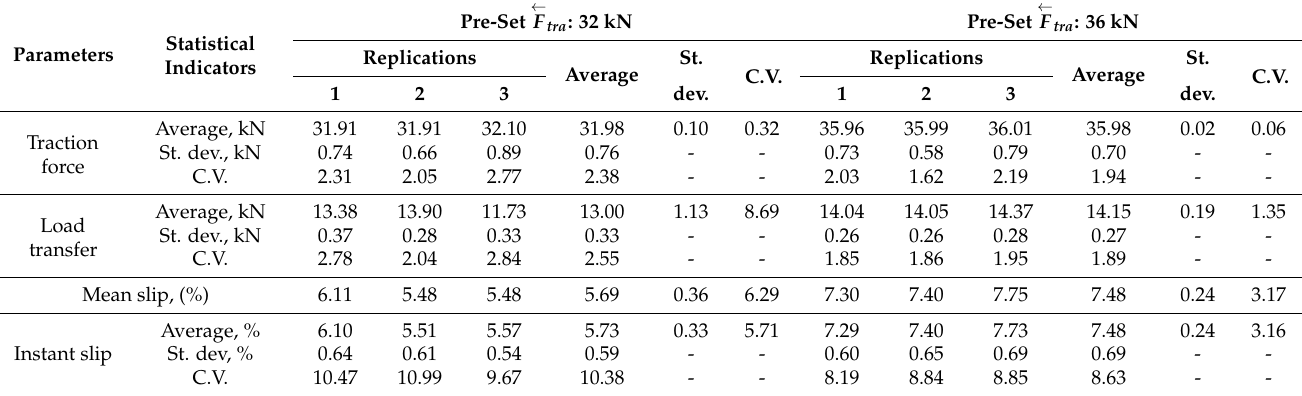
Table 7. Statistical indicators of the main parameters measured by the MTB for the pre ‐ set values of force of traction of 32 and 36 kN.